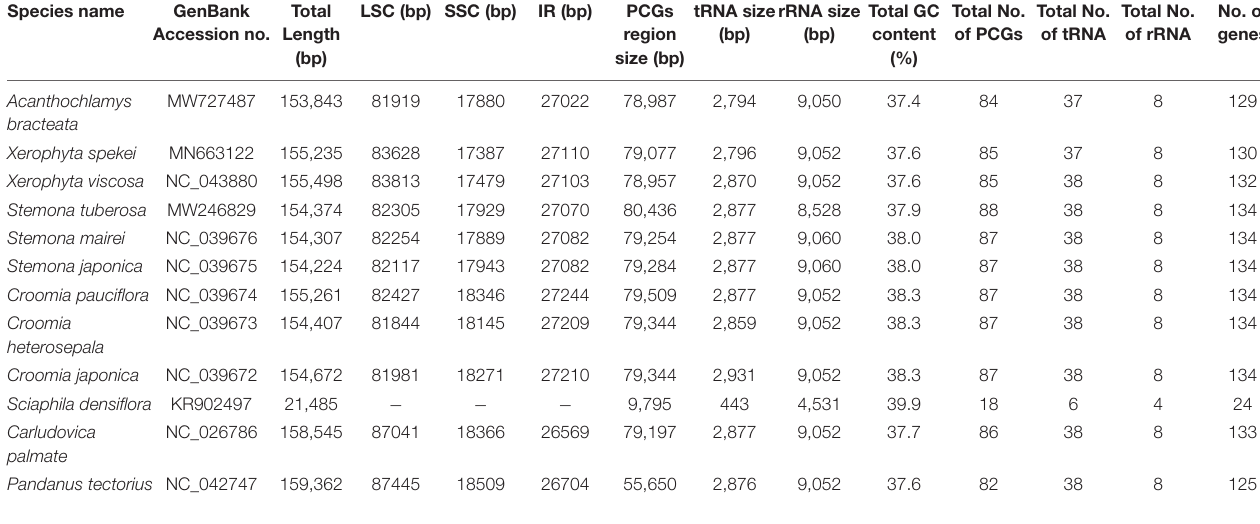
FIGURE 1 | Genome of map of: (A) Acanthochlamys bracteata ; (B) Xerophyta spekei , and Xerophyta viscosa . The genes shown inside and outside the circular maps are transcribed clockwise and anticlockwise directions, respectively. Genes from different functional groups are shown in different colors. The thick dark lines show the extent of the Inverted repeats (IRa and IRb) separating the Large Single-Copy (LSC) and the Small Single-Copy (SSC) regions. The dark gray and the light gray lies embedded inside the circle represent the GC and the AT content, respectively. TABLE 1 | Composition of Acanthochlamys bracteata , Xerophyta spekei , Xerophyta viscosa cp genomes with related species of the Order